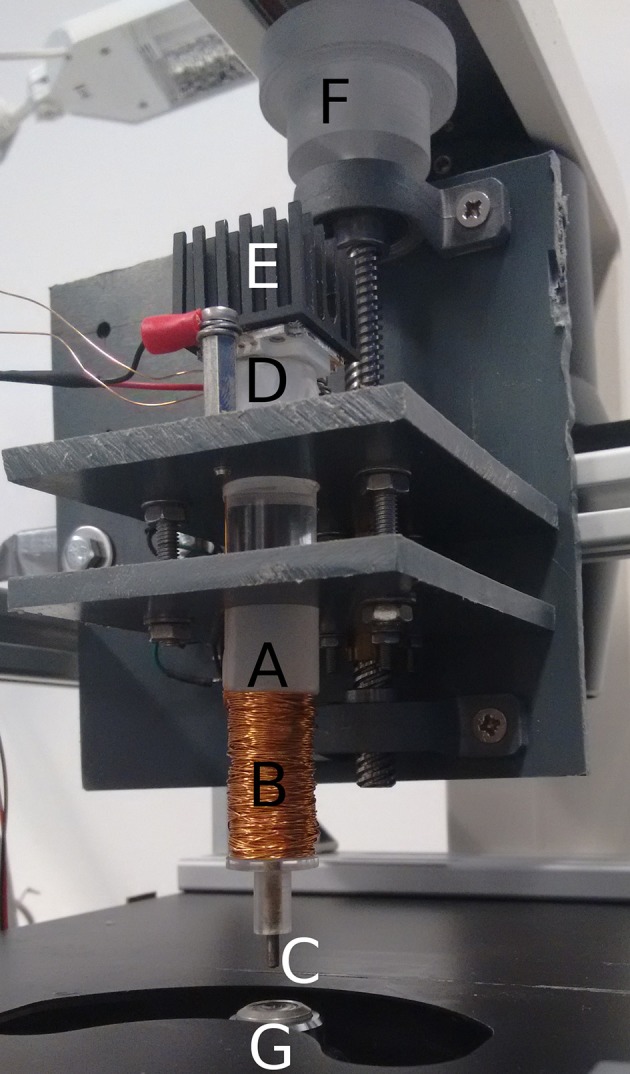
Setup of the illuminated electromagnet. Acrylic pole (A), copper coil (B), iron rod (C), LED-chip (D), heatsink (E), vertical positioning mechanism (F), objective of the microscope (G).